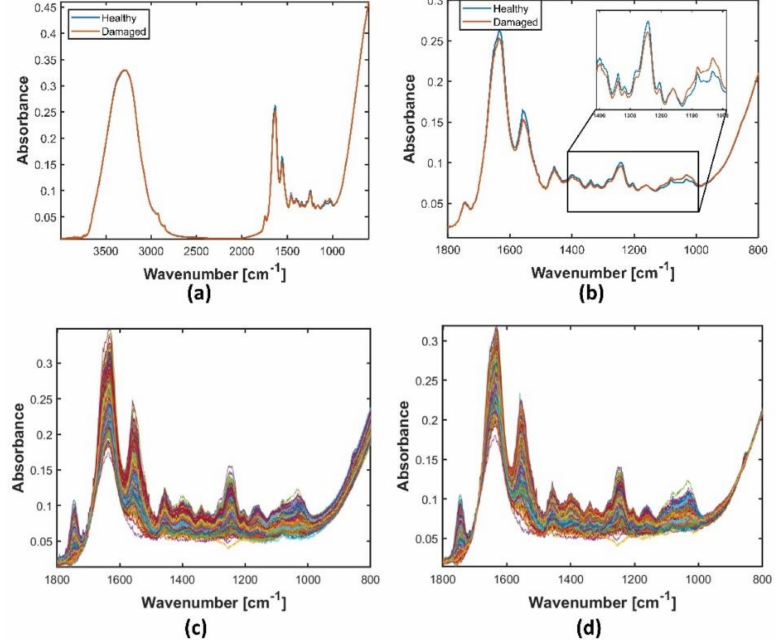
Figure 2. Simulated human cartilage spectra: mean spectra of simulated healthy (in blue) and damaged (in red) spectra showing ( a ) the full spectral range and ( b ) the fingerprint region; ( c ) all simulated apparent spectra in fingerprint region; ( d ) simulated spectra preprocessed by the weighted EMSC1 (MSC plus linear term)